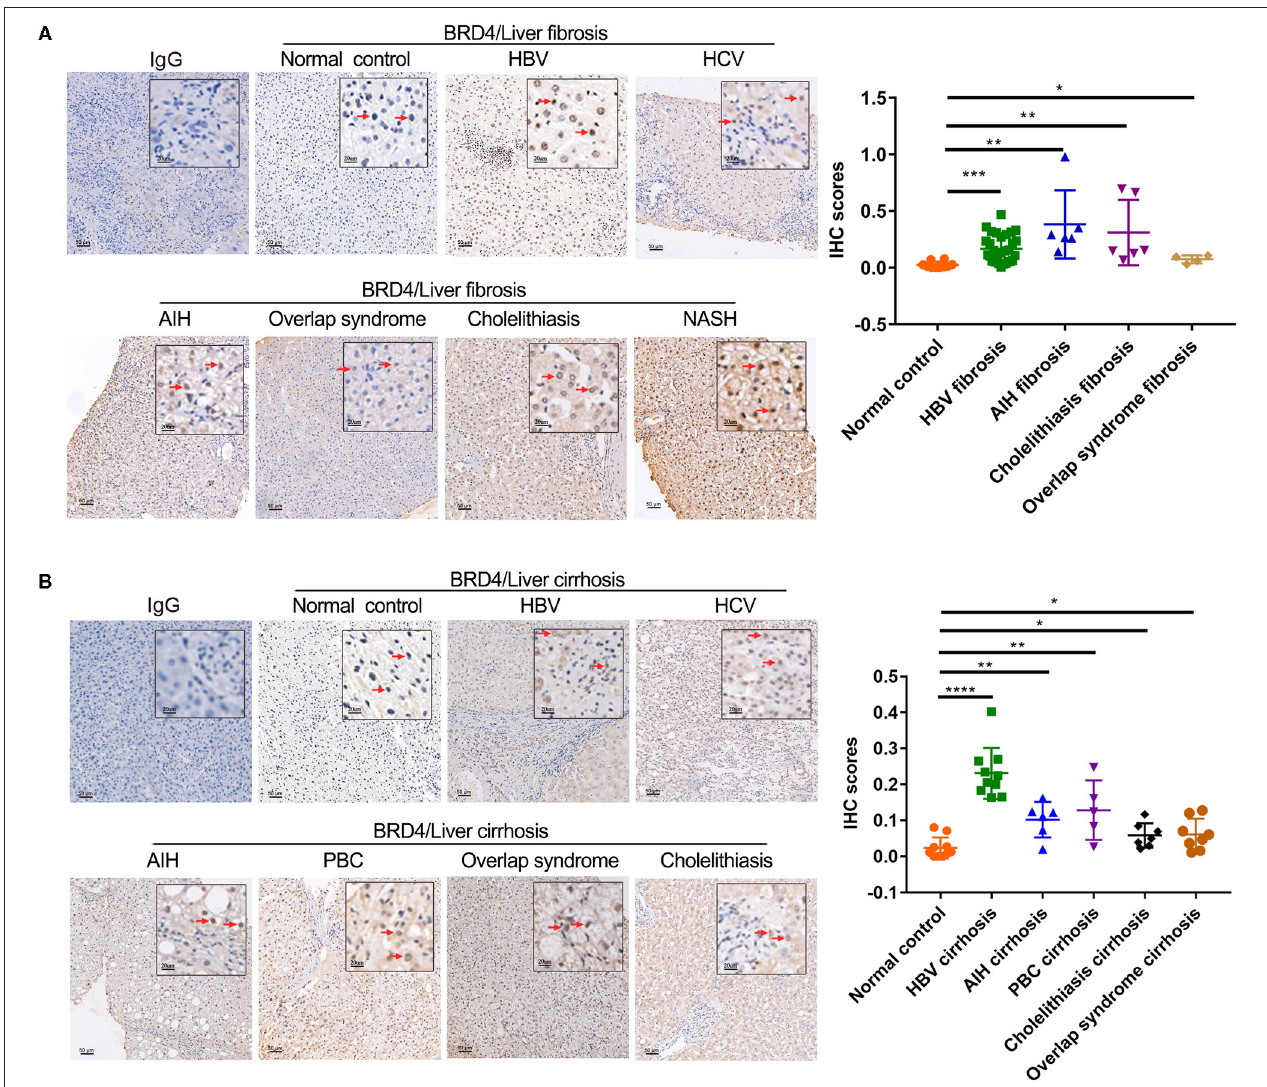
FIGURE 2 | Immunohistochemistry analysis of hepatic BRD4 protein expression in liver fibrosis/cirrhosis. (A) Immunohistochemistry analysis was performed to examine hepatic BRD4 protein expression patterns in normal liver tissues and liver fibrosis of various etiologies. The control sections were incubated with IgG. Representative images of normal hepatic tissues, HBV, HCV, AIH, NASH, cholelithiasis, and overlap syndrome. Scale bar: 50 µ m. The expression level of BRD4 was analysis by Image J software. Data were expressed as mean ± SEM or median M (P25, P75). Differences between groups were evaluated using two independent samples t -test or Mann-Whitney U rank-sum test. (B) Immunohistochemistry analysis was performed to examine hepatic BRD4 protein expression patterns in normal liver tissues and liver cirrhosis of various etiologies. The control sections were incubated with IgG. Representative images of normal hepatic tissues, HBV, HCV, AIH, PBC, cholelithiasis, and overlap syndrome. Scale bar: 50 µ m. The expression level of BRD4 was analysis by Image J software. Data were expressed as mean ± SEM or median M (P25, P75). Differences between groups were evaluated using two independent samples t -test or Mann-Whitney U rank-sum test. * P < 0.05; ** P < 0.01; *** P < 0.0001; **** P < 0.00001 vs. normal control. BRD4, bromodomain-containing protein 4; HBV, hepatitis B virus; HCV, hepatitis C virus; AIH, autoimmune hepatitis; NASH, non-alcoholic steatohepatitis; PBC, primary sclerosing